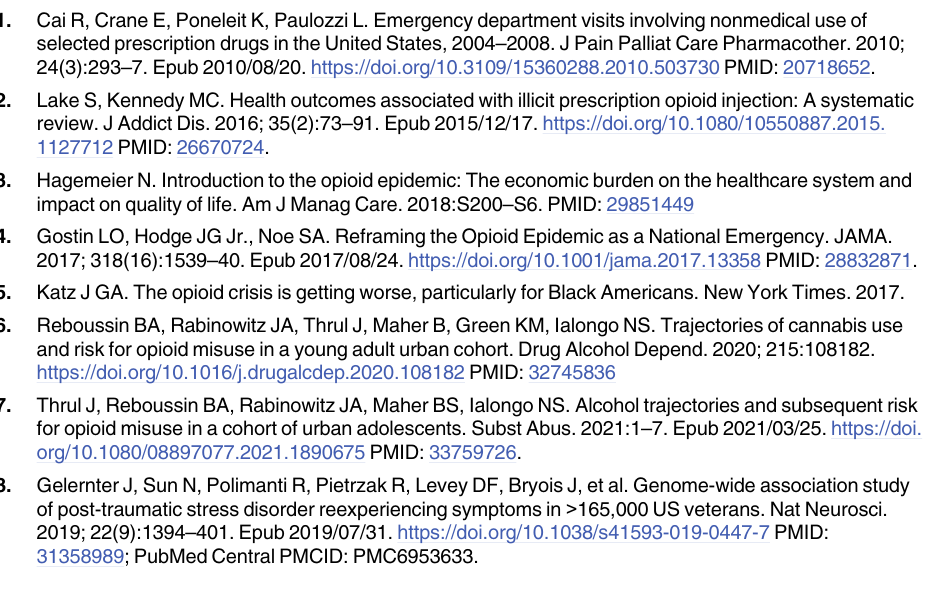
S1 Table. Main effects of the covariates in predicting phenotypic opioid misuse in the whole sample and among males and